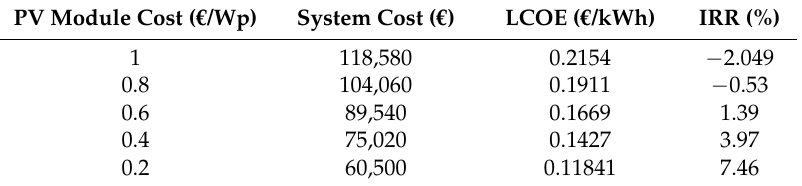
Table 8. Comparison of LCOE and IRR based on a recovery factor at 10% interest for the 50 kW case. PV Module Cost ( €